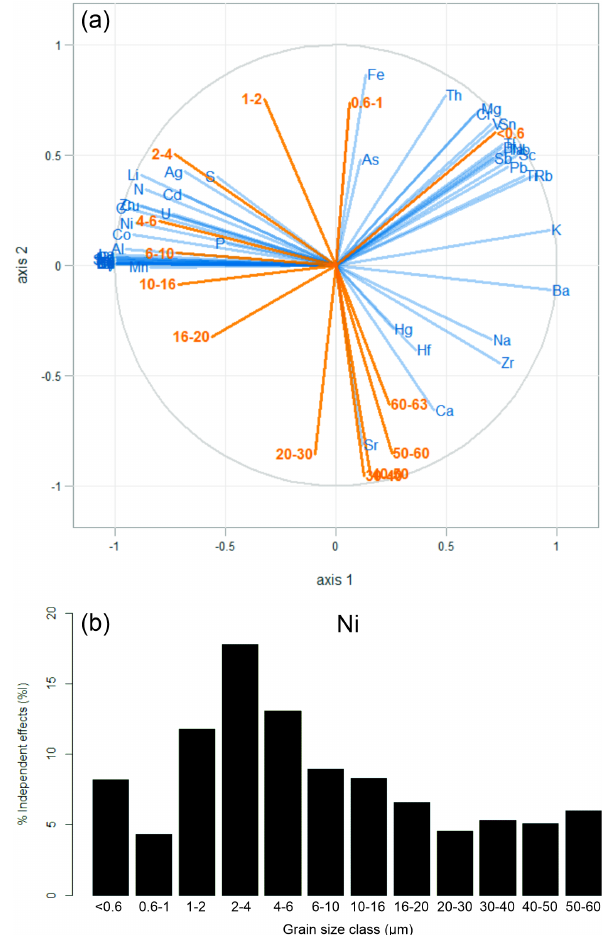
Figure 4. (a) Correlation loading plot of the PLSR2 analysis for 54 predictor variables (blue – elements) and 13 response variables (orange – grain size classes in µm). (b) Hierarchical partitioning result plot, showing the independent contribution (%) of each grain size class to predicted Ni